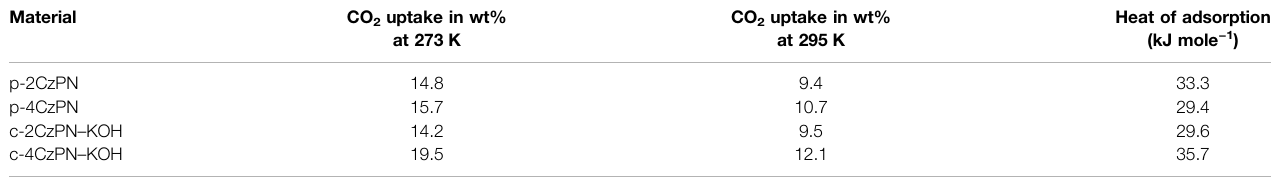
TABLE 2 | CO 2 adsorption capacities of p-2CzPN, p-4CzPN, c-2CzPN – KOH, and c-4CzPN – KOH. Material